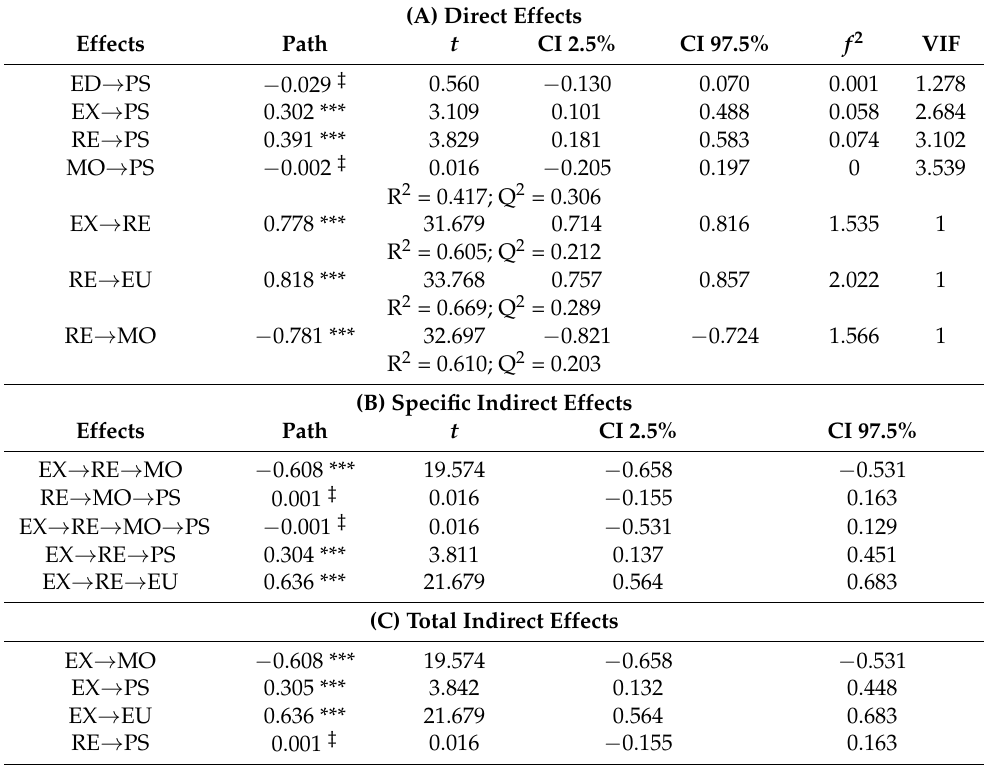
Table 6. Assessment of the structural model for men.